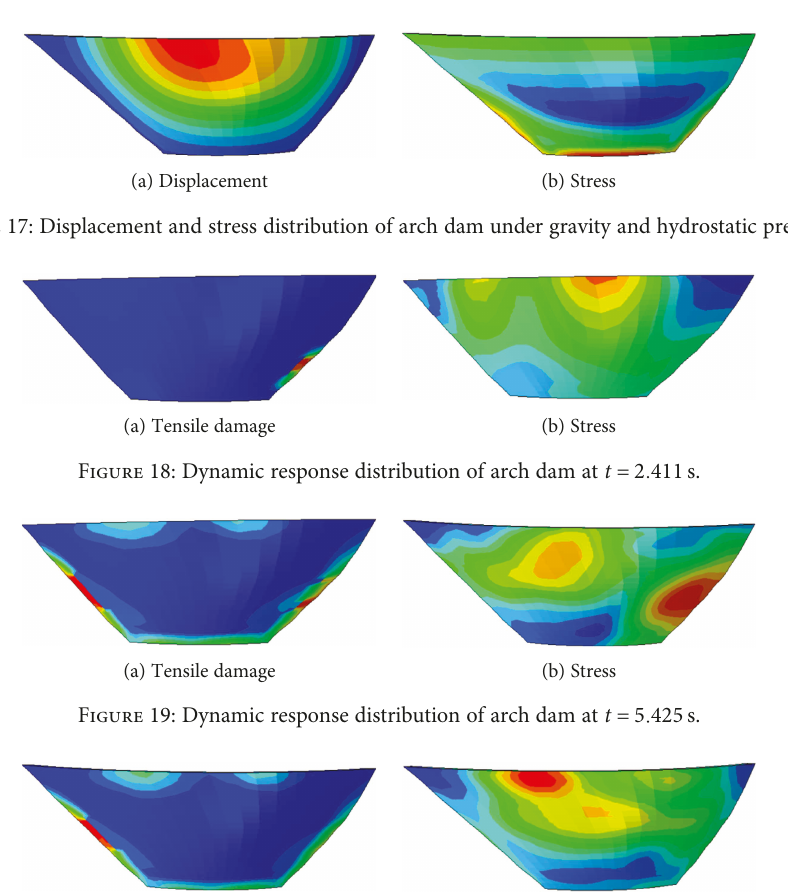
Figure 16: Displacement and stress distribution of arch dam under gravity.